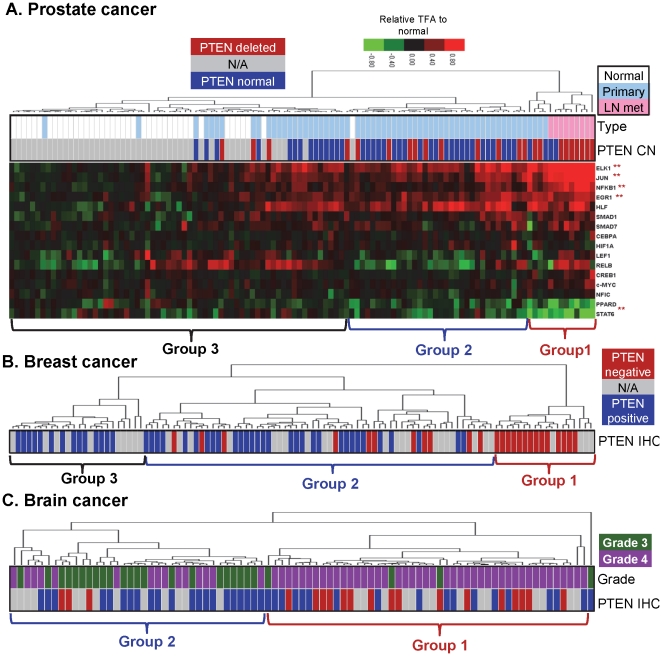
PTEN-controlled TFAs predict PTEN status in human cancers.Unsupervised clustering analysis, based on PTEN-controlled TFAs, was used to classify human tumor samples. (A) In prostate cancer, group 1 is largely composed by samples with PTEN copy number changes (CN, red) and lymph node metastases (LN met, pink); Group 2 are primary cancer samples (light blue) with normal PTEN karyotype (blue) that are separated from most of normal prostate tissues (white). TFAs that are significantly altered between group 1 and group 3 are mark by **, p<0.001. The heatmap was plotted based on relative changes to the respective average TFAs of normal samples. (B) In breast cancer, group 1 is mostly comprised of samples with PTEN-negative status (red) identified by immunohistochemistry (IHC). The majority of the samples in group 3 have positive PTEN status (blue), while group 2 includes both positive and negative PTEN samples. (C) In brain tumors, most samples in group 1 are associated with PTEN negative status (red). The PTEN negative subgroup is also correlated with higher tumor grade (green for grade 3 and purple for 4, respectively).